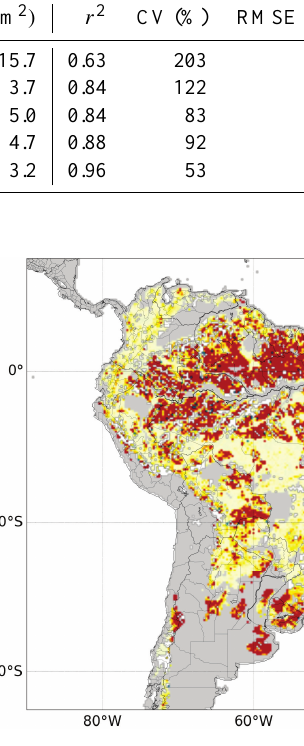
Table 1. Statistics for the comparison between GFC forest loss (km 2 yr − 1 ) and IYD (yr − 1 ) . This was done for all grid cells and when aggregating the grid cells in a country-level analysis. The coefficient of variation (CV in %) was based on the Root Mean Square Error (RMSE in km 2 ) between both data sets. VOD bin Based on all grid cells Country level Slope r 2